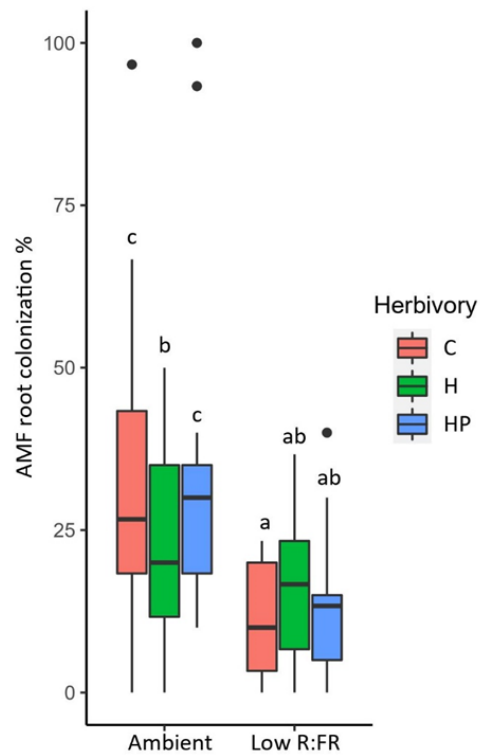
Figure 1. Percentage of tomato roots colonized by AMF under different conditions of light (ambient; low R:FR light) and herbivory. (C = no herbivory; H = herbivory by unparasitized caterpillars; HP = herbivory by parasitized caterpillars). Boxplots that don’t share the same letter are significantly different p < 0.05 (Tukey HSD). The median is represented by the thick horizontal line; the box is defined by the 25th and 75th percentiles (lower and upper quartile).